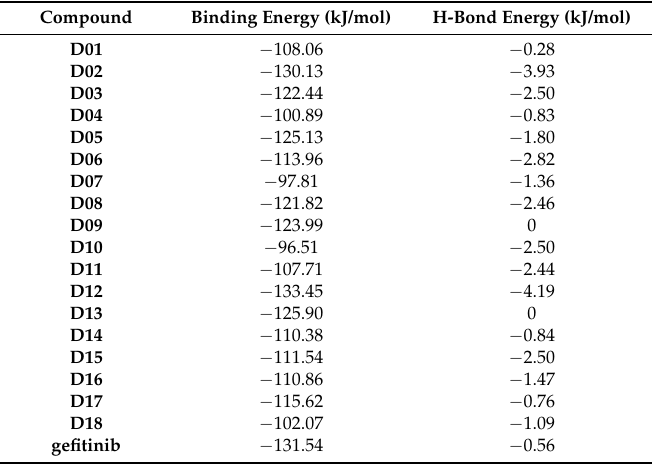
Table 1. The results of the docking studies.